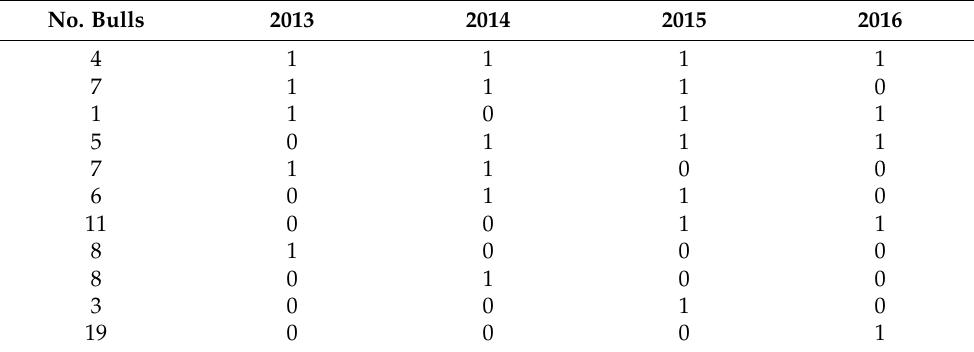
Table 2. Patterns of edited bull usage by calf birth year.